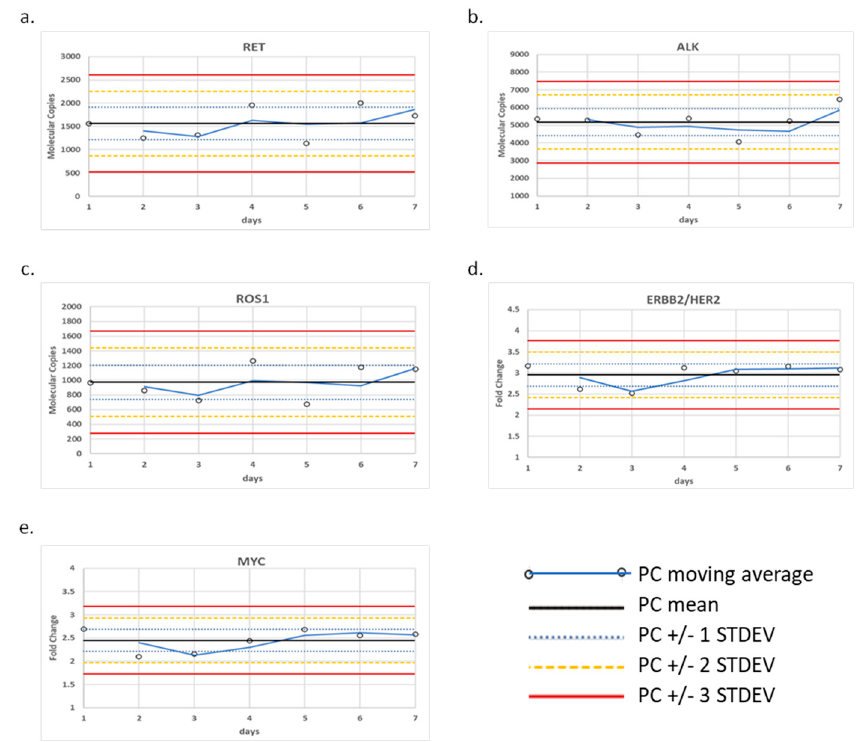
Figure 1. Control charts for CNA and fusion/skipping variant types. ( a ) CCDC6-RET fusion, ( b ) EML4-ALK fusion, ( c ) CD74-ROS1 fusion, ( d ) ERBB2/HER2 amplification, and ( e ) MYC amplifi- cation detected within the positive control over seven days of testing. Table 1. Analytic sensitivity for the fusion/skipping variant